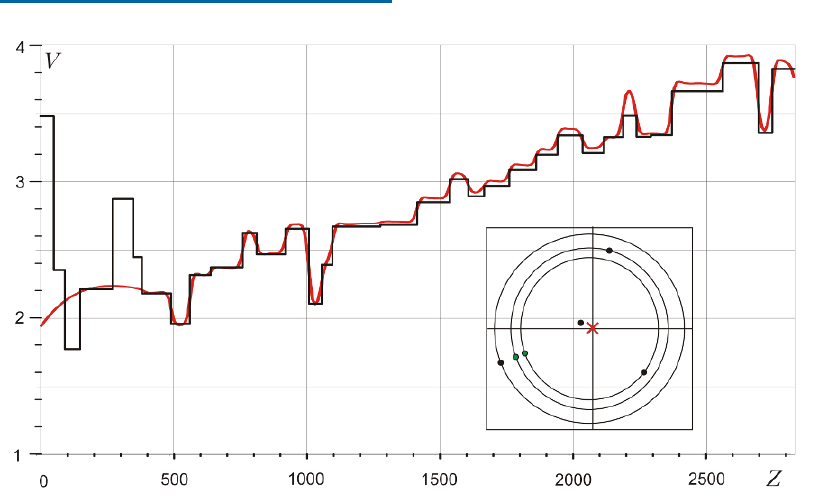
Figure 3. The dependence of the velocity on depth. The theoretical